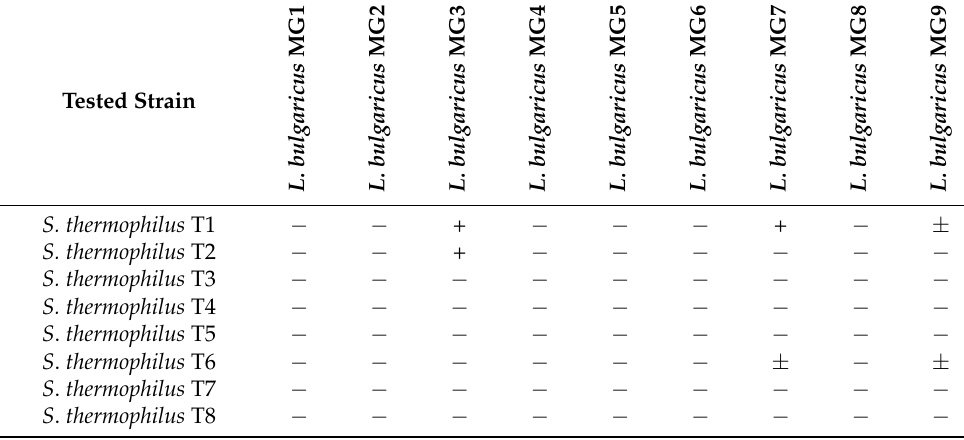
Table 1. Biocompatibility of the Lactobacillus delbrueckii subsp. bulgaricus and Streptococcus salivarius subsp. thermophilus